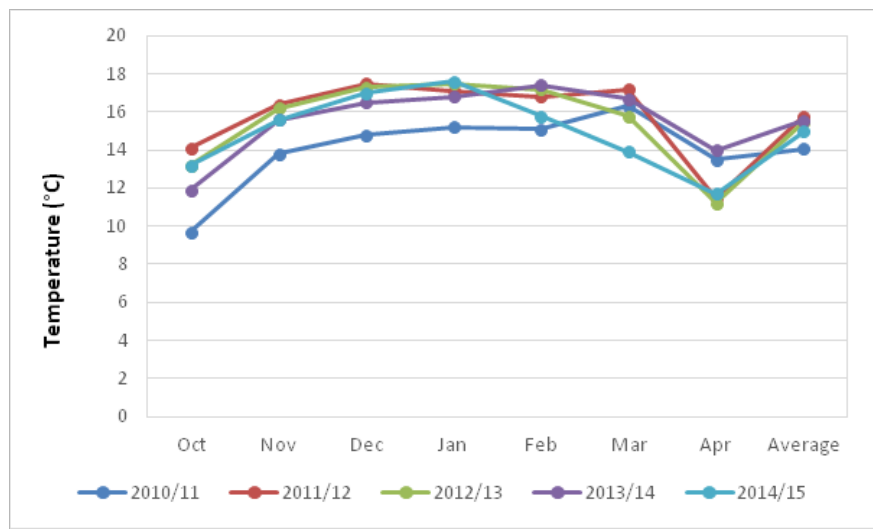
Figure 6 : Mean minimum ground temperatures recorded over five seasons (2010-2015)